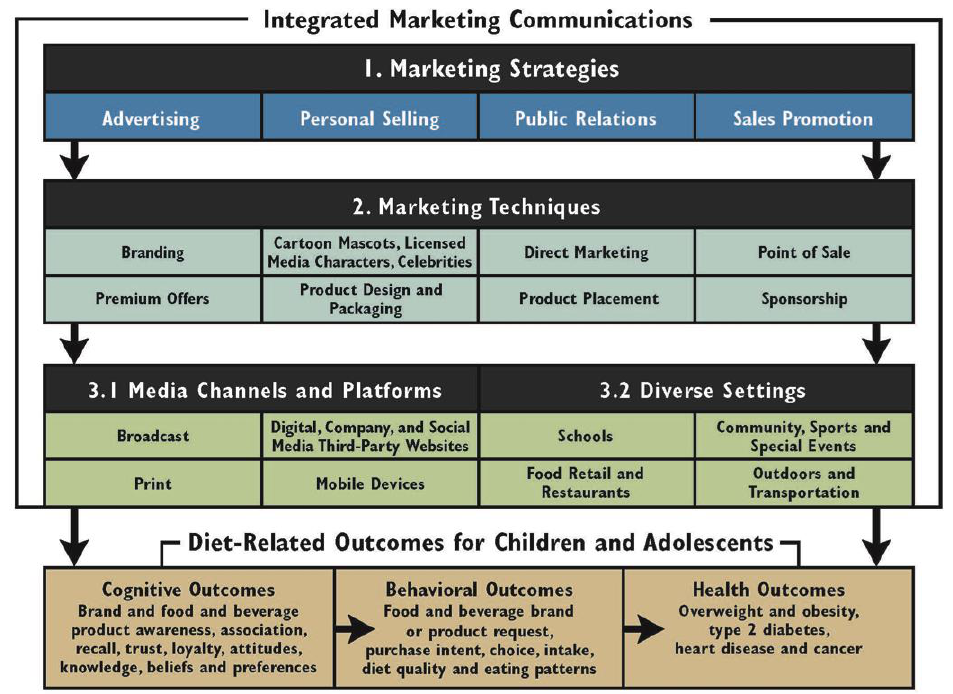
Figure 2. Integrated Marketing Communications Framework of marketing strategies that influence diet-related outcomes for children [25]. Reprinted with permission (figure has copyright permission from the authors).